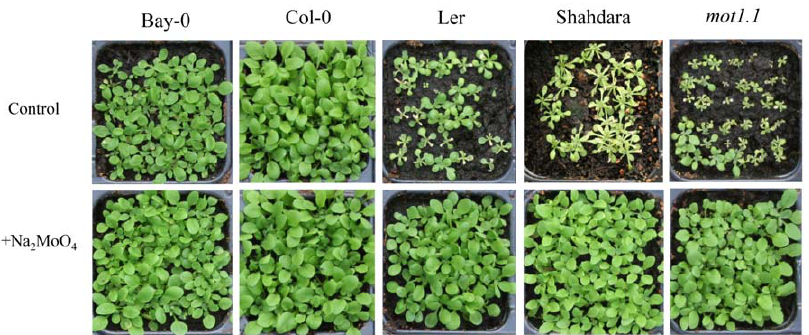
Figure 3. Chemical complementation links growth defect with Mo shortage. Accessions with potentially functional (Bay-0, Col-0) and defective MOT1 alleles (L er , Shahdara, mot1.1 ) were grown on peatmoss substrate watered with nutrient solution containing either traces of Mo (‘Control’) as in Figure 1, or 1 mM Na 2 MoO 4 (‘ + Na 2 MoO 4 ’). pH was checked to remain unchanged across treatments at , 5.